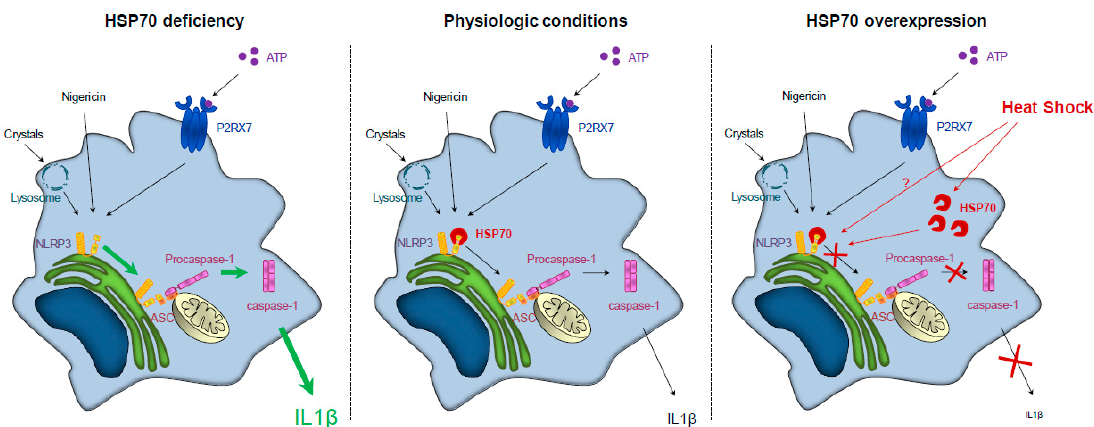
Figure 1. HSP70 (Heat Shock Protein 70) expression regulates NLRP3 (NOD-leucine rich repeat and pyrin containing protein 3) inflammasome activation. Left panel: HSP70 deficiency leads to an overactivation of NLRP3 inflammasome and caspase-1 and to an increased secretion of IL (interleukin)-1 β . Middle panel: In physiologic conditions, NLRP3 inflammasome activation and IL-1 β secretion are regulated. Right panel: HSP70 overexpression (artificially or through a heat shock) leads to the continued interaction between HSP70 and NLRP3, preventing the interaction between NLRP3 and ASC (Apoptosis associated Speck-like protein containing a CARD domain) and the subsequent caspase-1 activation and IL-1 β secretion.